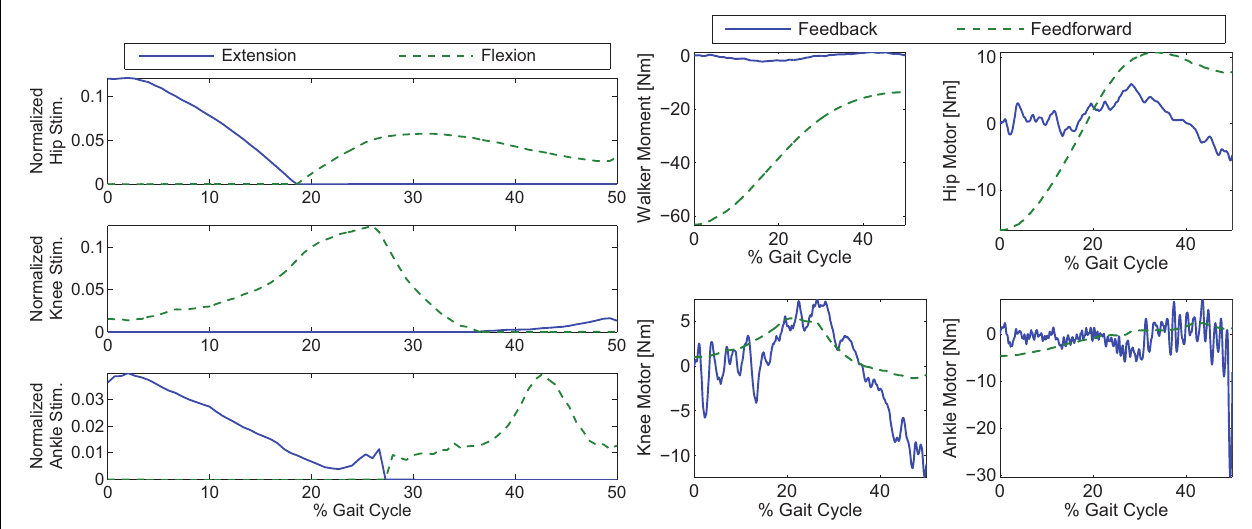
FIGURE 9 | Control inputs for Case 4 of the simulations . The feedback’s contribution was used only in the walker moment and motor torques.